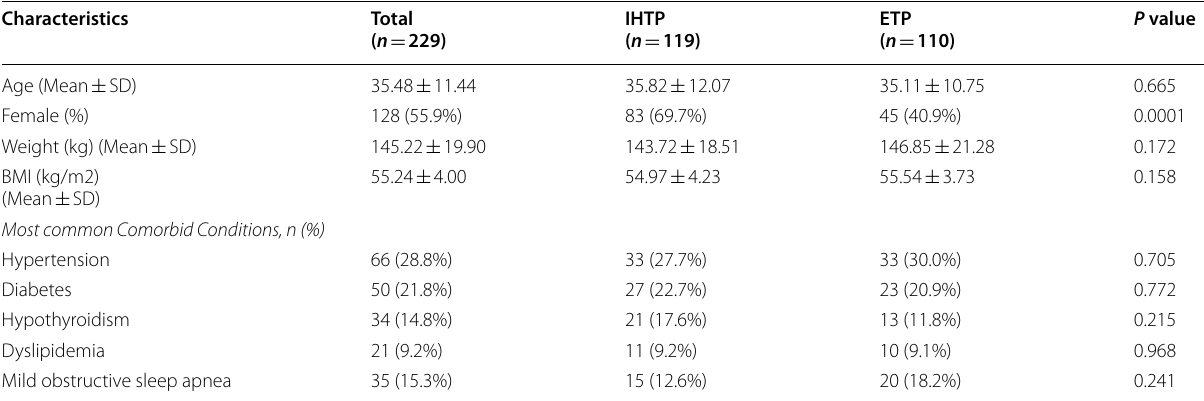
Table 1 Baseline demographic and clinical characteristics of patients who received either in-hospital (IHTP) or extended thromboprophylaxis (ETP), N 229 =